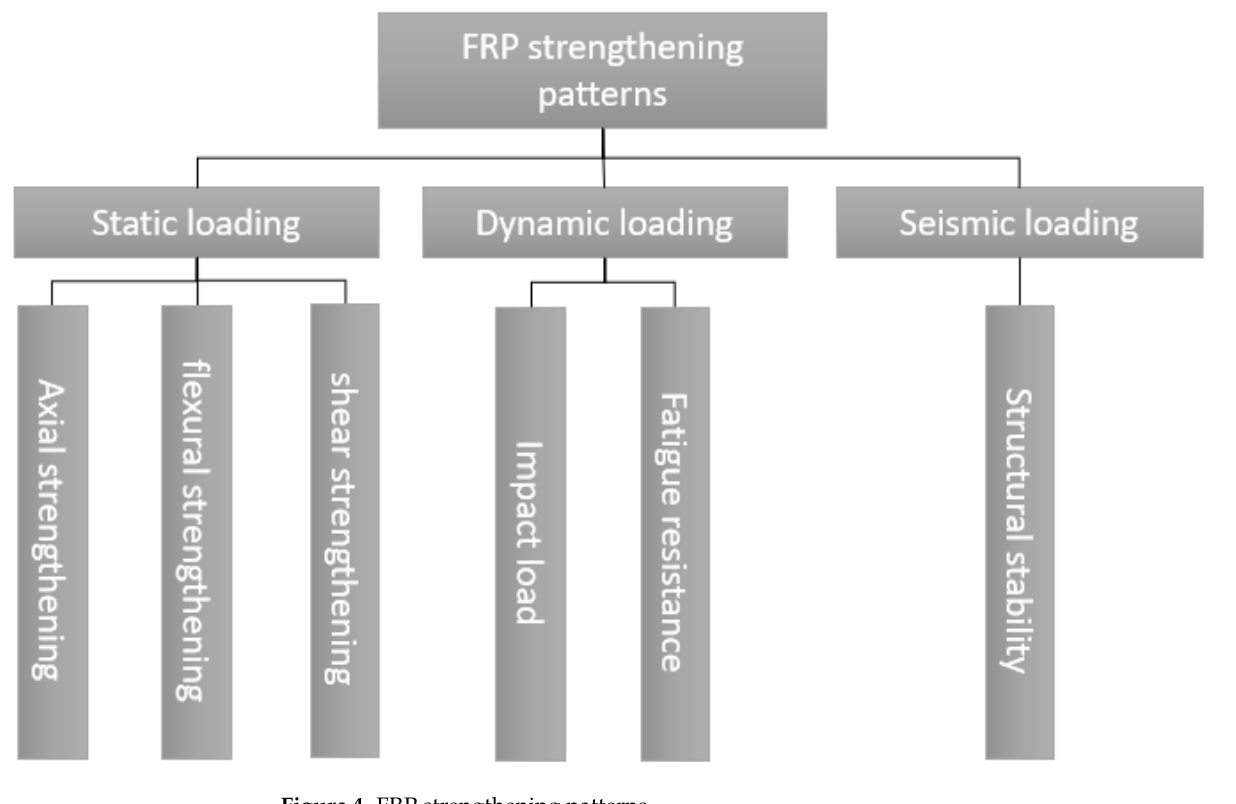
Figure 4. FRP strengthening